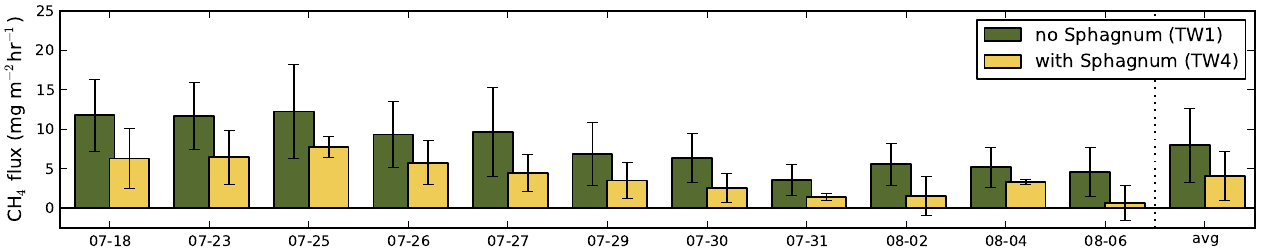
Fig. 3. Daily fluxes for terrain types without (TW1) and with Sphagnum (TW4). Measurements are shown per day and on the right the average flux of the two vegetation types is shown. Error bars denote the standard deviation of the measurements.